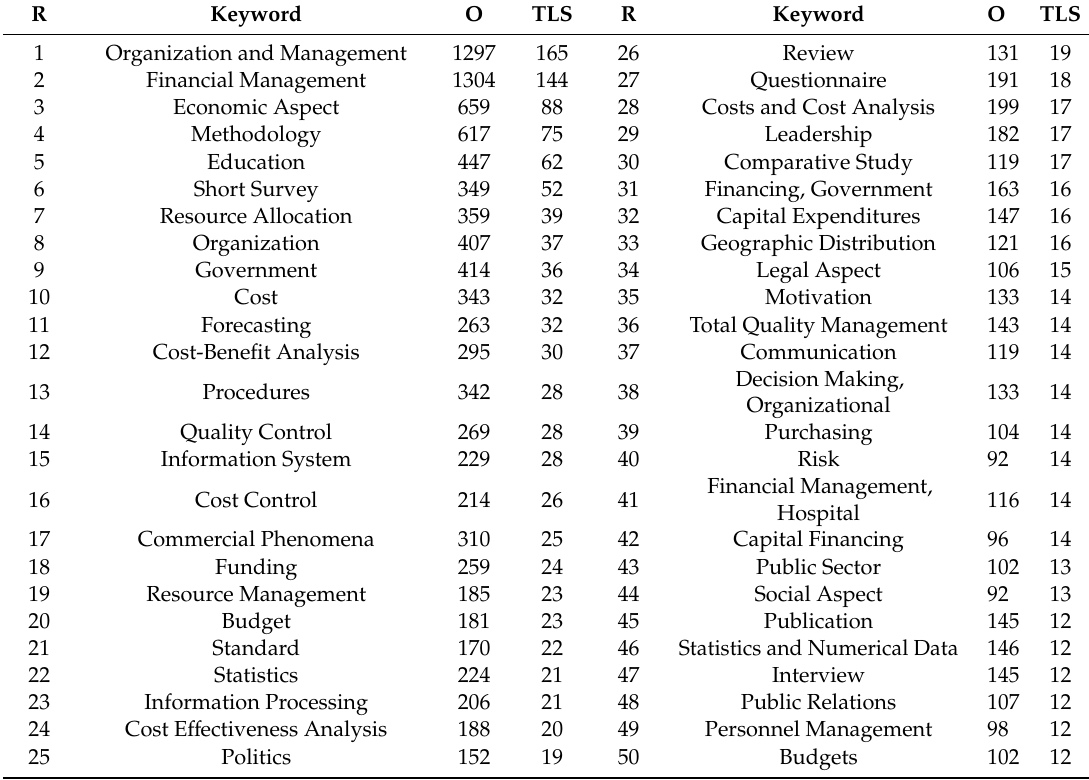
Table 6. Cluster 2. Top 50 keywords (1975–2019).